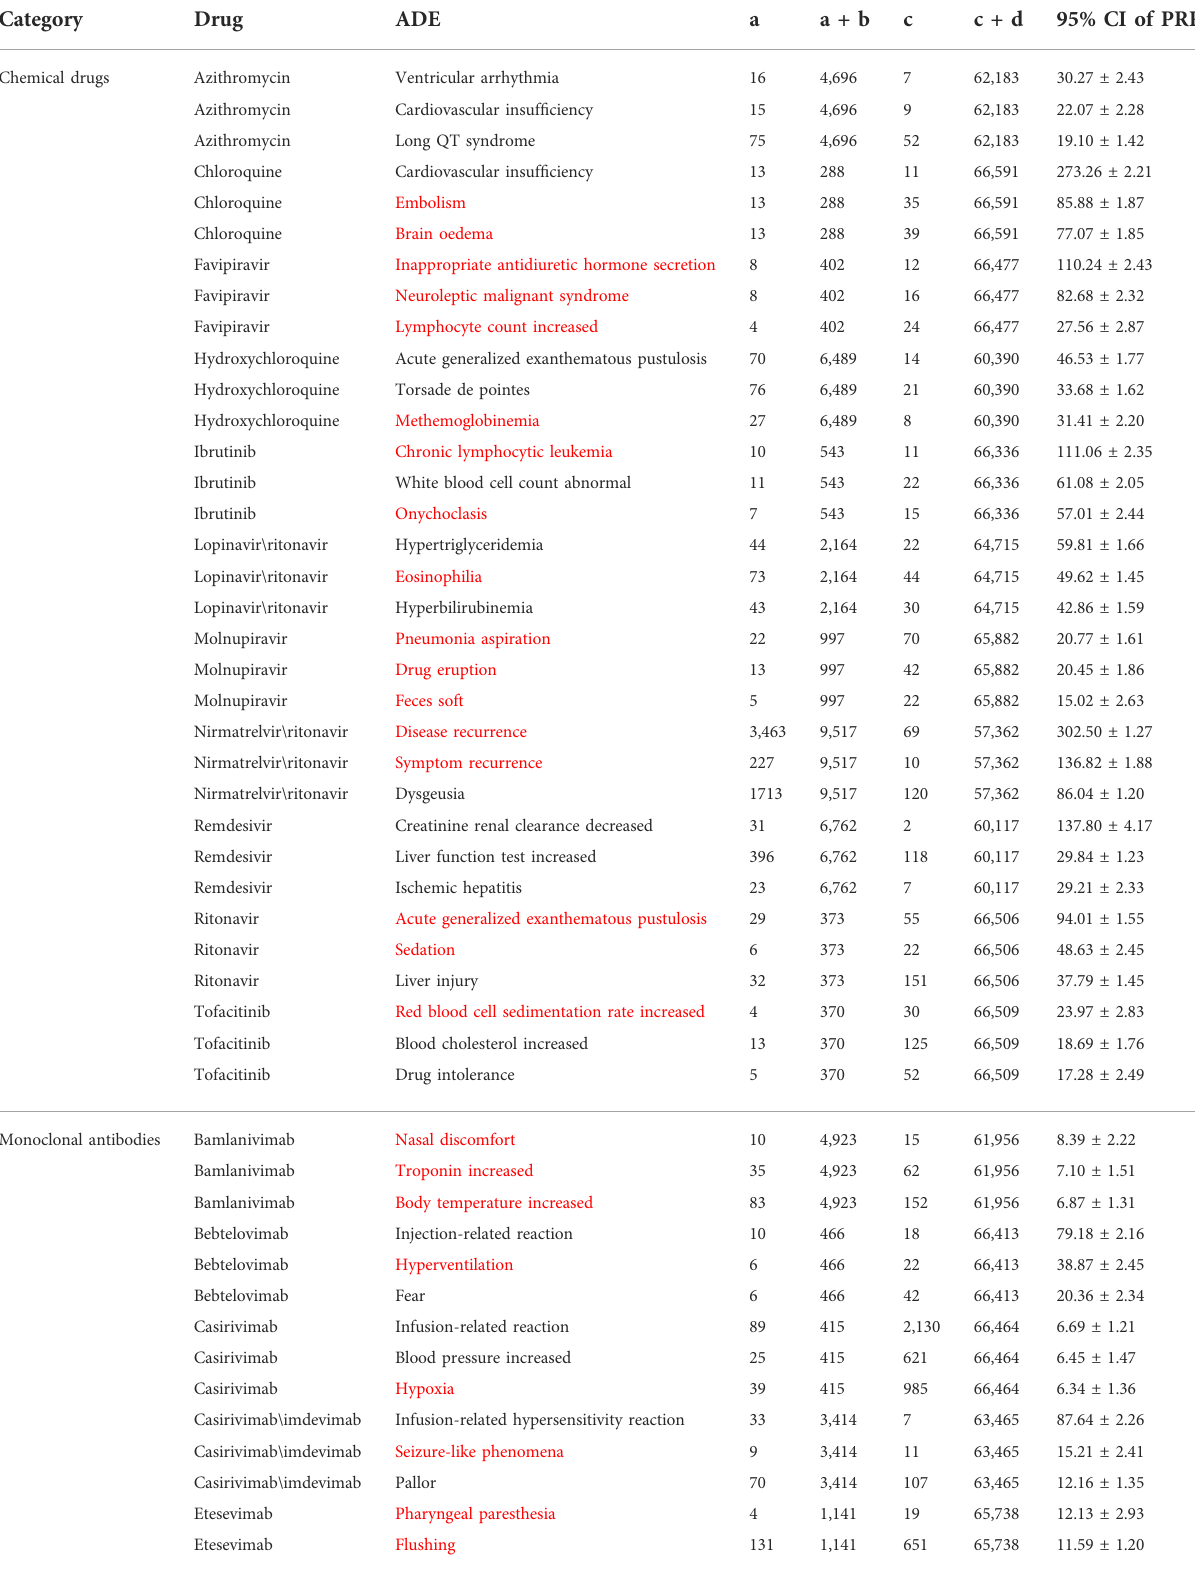
TABLE 4 Top ADE signals of hot drugs on the PT level. a